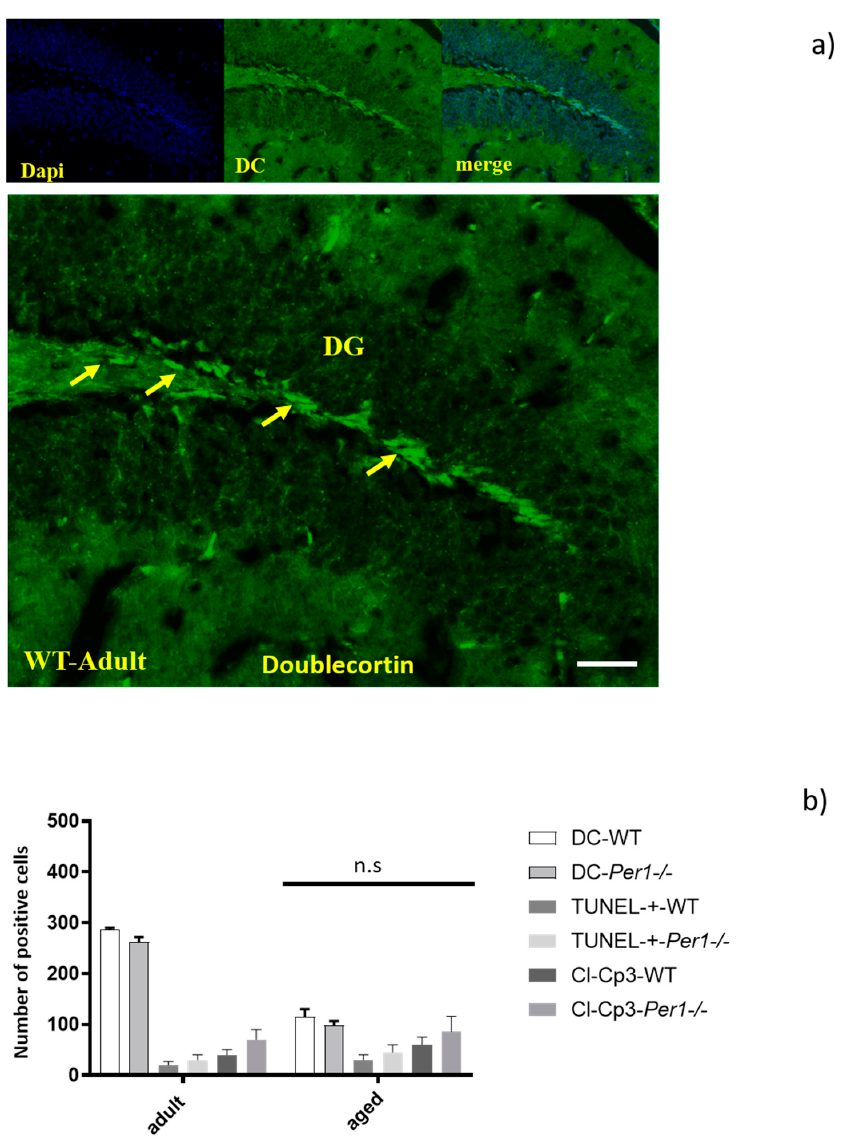
Figure 7. ( a , b ) The decreased number of Doublecortin-positive cells (DC) in the dentate gyrus was similar in both genotypes. There is a progressive decrease with age, but in a similar manner within groups ( a ). We found that Per1 deficiency did not alter the apoptotic cell death in the hippocampus in aged mice, because the density of caspase-3-positive cells as well as of TUNEL-positive cells was similar in all age groups ( b ). Therefore, we assume that Per1 has no influence on the proliferation or apoptosis of granule cells. Data are reported as means ± SD of three experiments. Scale bar 100 μ m.